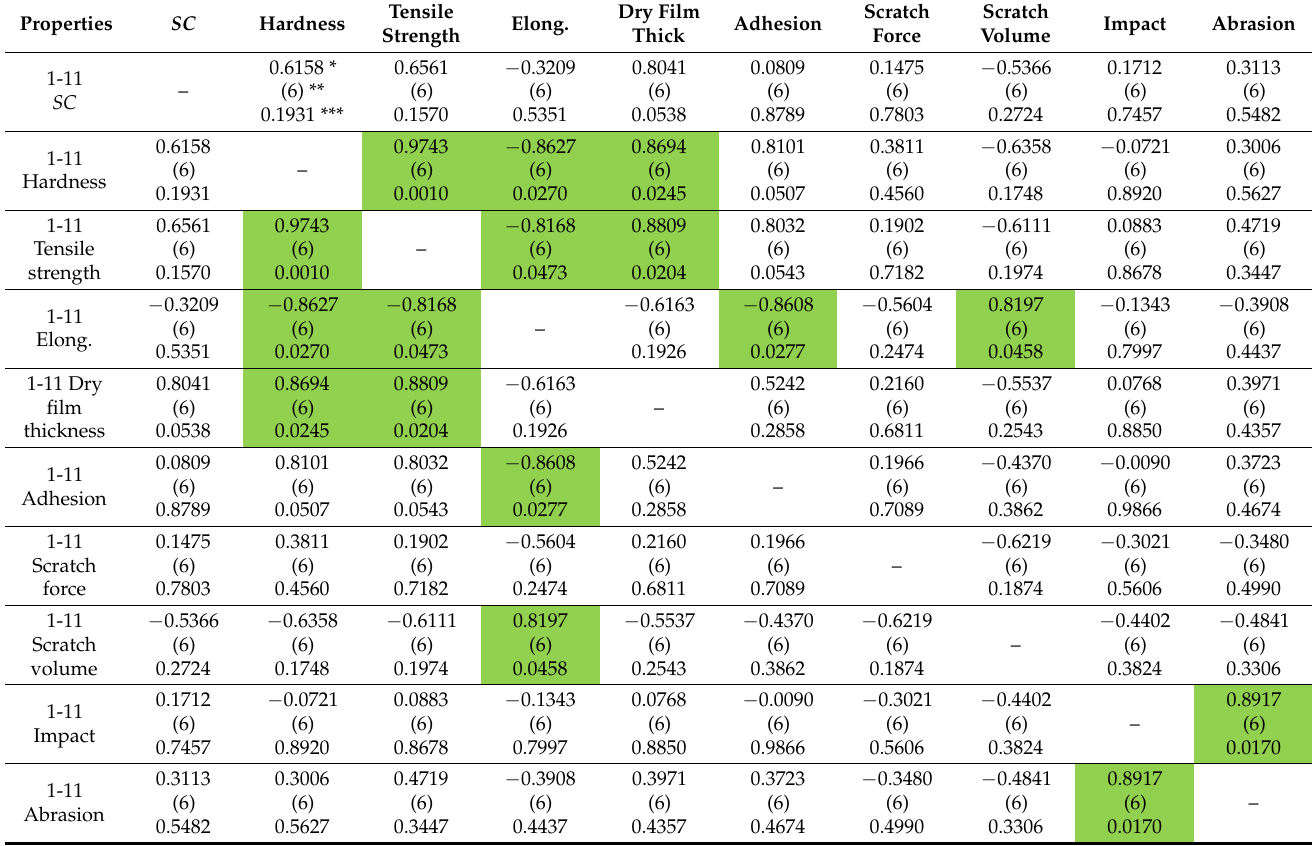
Table 8. Correlation matrix of coatings and flooring surface systems